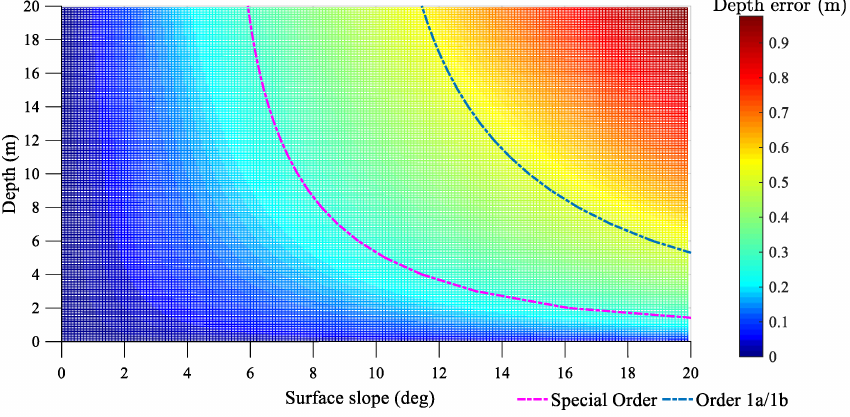
Figure 24. The relationship between sounding error vs. depth and surface inclination. Table 12. The influence of sea surface inclination in different depth ranges on the sounding results. Special Order Special Order Depth (m)